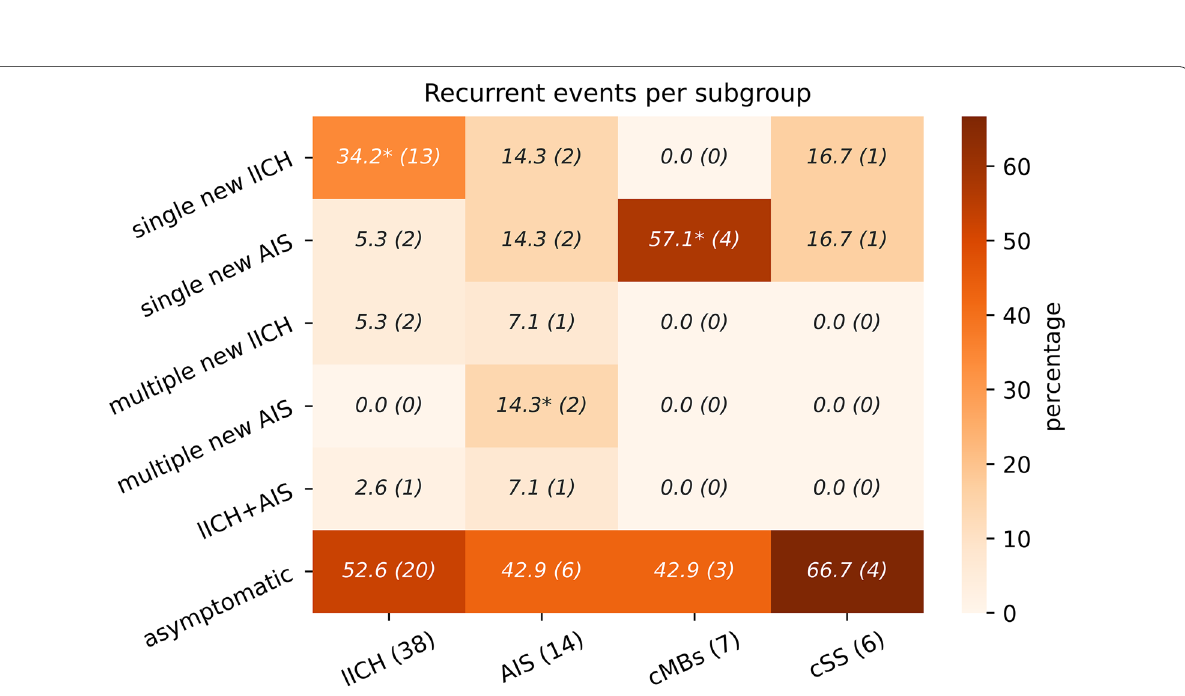
significant compared to the three other groups each =